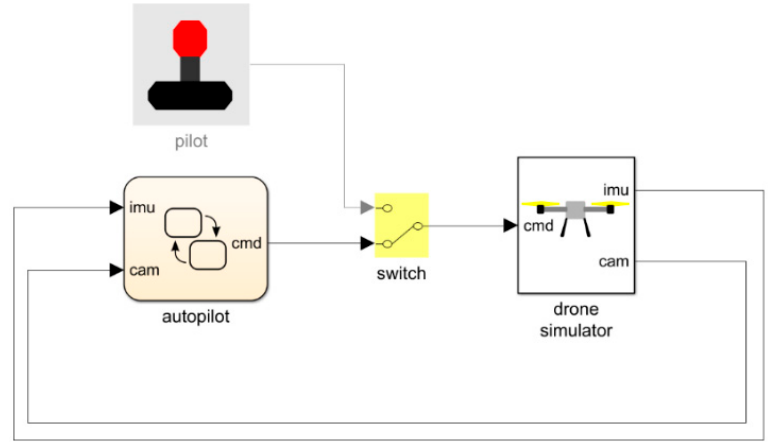
Figure 3. Autonomous navigation system developed in Simulink: the autopilot block is the Stateflow state machine implementing the navigation system; the pilot block manages a joystick in case of manual navigation; the switch block allows the change between autonomous and manual flight; and the drone simulator block incorporates the vision subsystem, as well as the interaction with Gazebo.